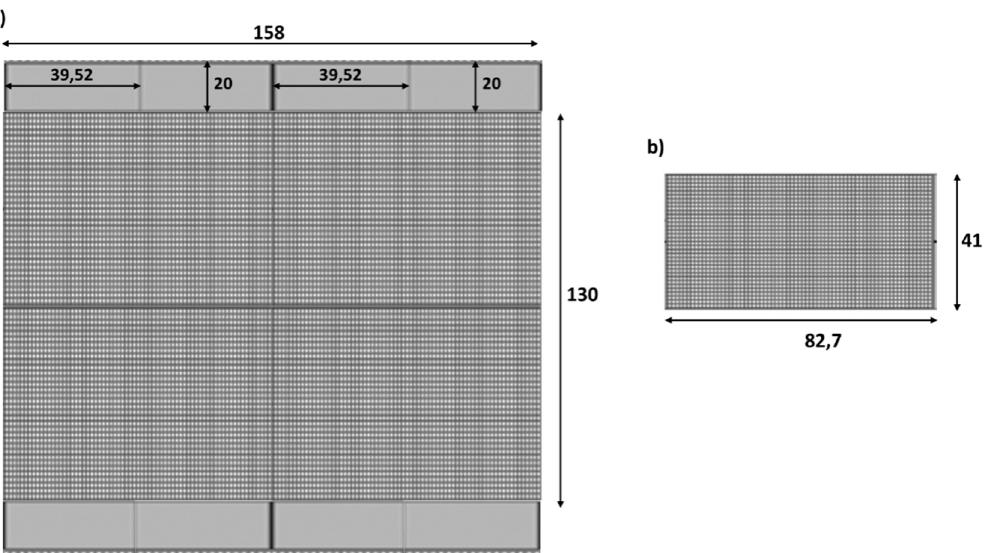
4 of 18 Figure 1. Dimensions (cm) of continuously grouped (C1) colony cage: ( a ) front view, ( b ) side view, ( c ) lateral view. Two different colony cages were developed in collaboration with Metac–Ellebis.r.l. manufacturing (Fabriano, Italy): - Simple colony cage (C1; Figure 1), with dimensions of 76W × 150L × 60H cm, and four external shut-out nest boxes (38 × 25 × 35 cm) at each side of the cage. - Combination colony cage (C2; Figure 2) with two levels: in the lower level, the maternity cage was located with eight units and nests, divided into two sides (four rabbit does per side), furnished with removable walls to manage group and individual housing, depending on the different production phases. The dimensions of cage were of 130W × 158L × 60H cm, with eight 39.52 × 20 × 35cm external shut-out nest boxes at each side of the cage. In the upper level, there was a multi-purpose cage with removable walls, available for hosting the non-pregnant and severely injured does and for potential sopra-numerous pregnant does (possibility to add nests).